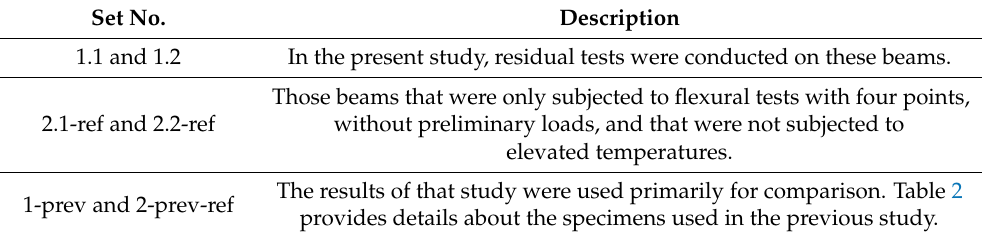
Table 1. General procedure with regard to considered sets.